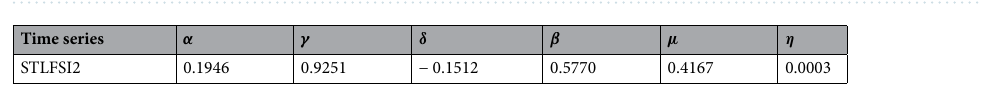
Table 3. Parameters of the Rulkov map used for the STLFSI2 data set.